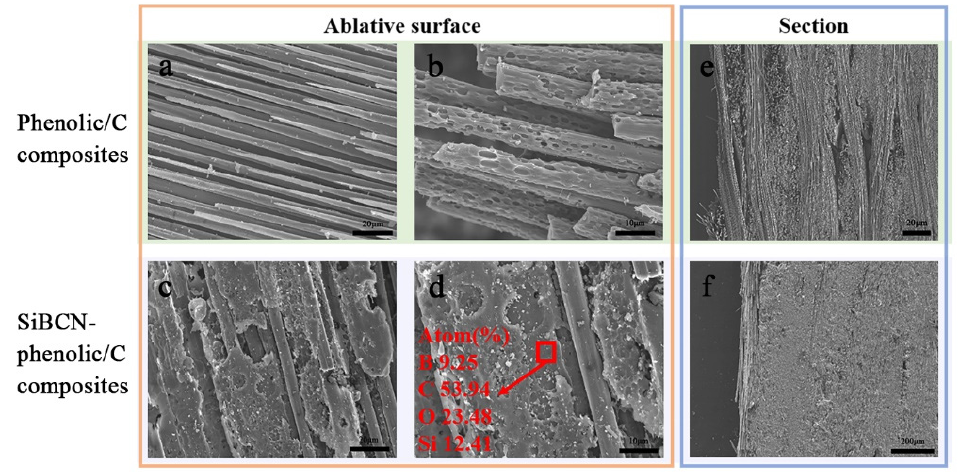
Figure 9. SEM images of the surface ( a , b ) and the section ( e ) for the ablated phenolic/C composites, SEM images of the surface ( c , d ) and the section ( f ) for the SiBCN–phenolic/C composites.